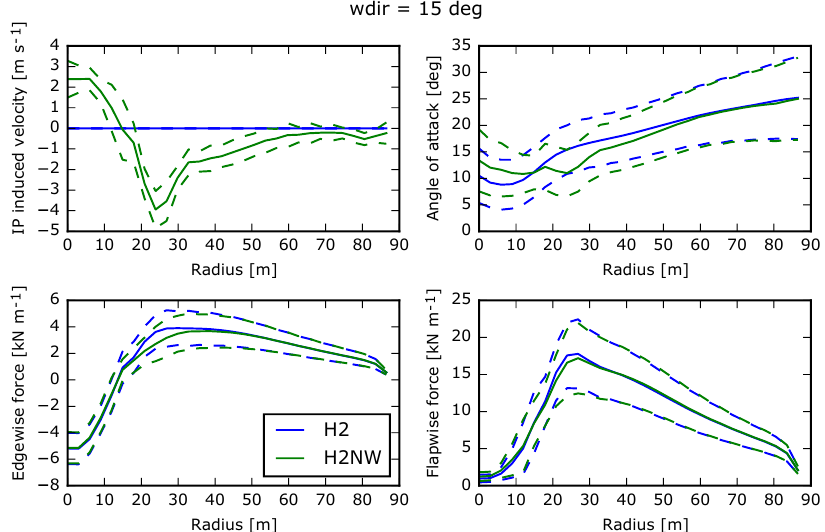
Figure 12. Distribution of induction, AOA, and loads for the upward-pointing blade. The mean values are shown as solid lines, and the dashed lines indicate the standard deviations.